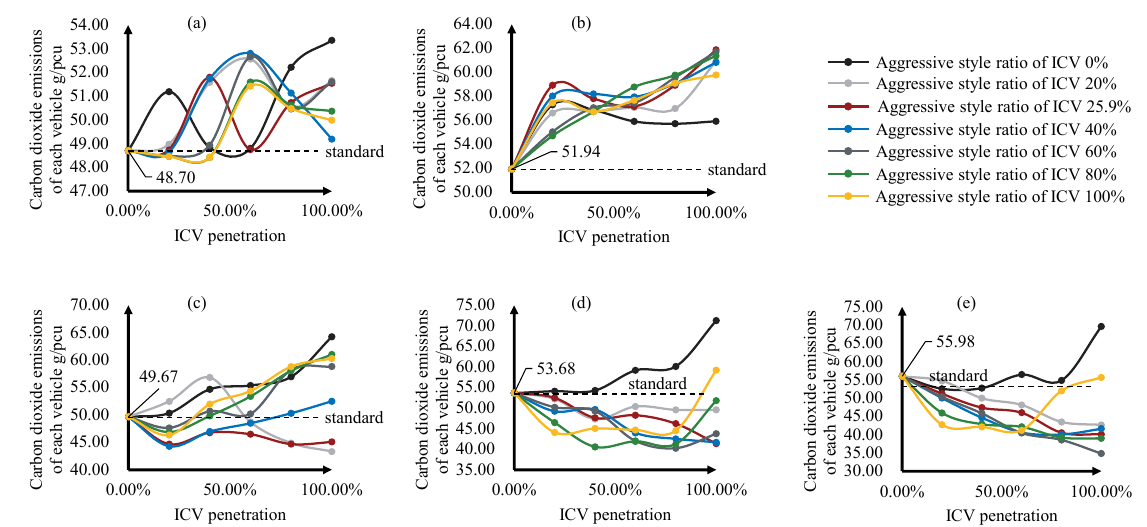
Figure 8. The impacts of SLADS on the average CO 2 emissions per vehicle of the expressway under different driving styles with the volume input being equal to the first service level ( a ), the third service level ( b ), the saturated service level ( c ), and the 20% ( d ) and 40% ( e ) oversaturated service level.